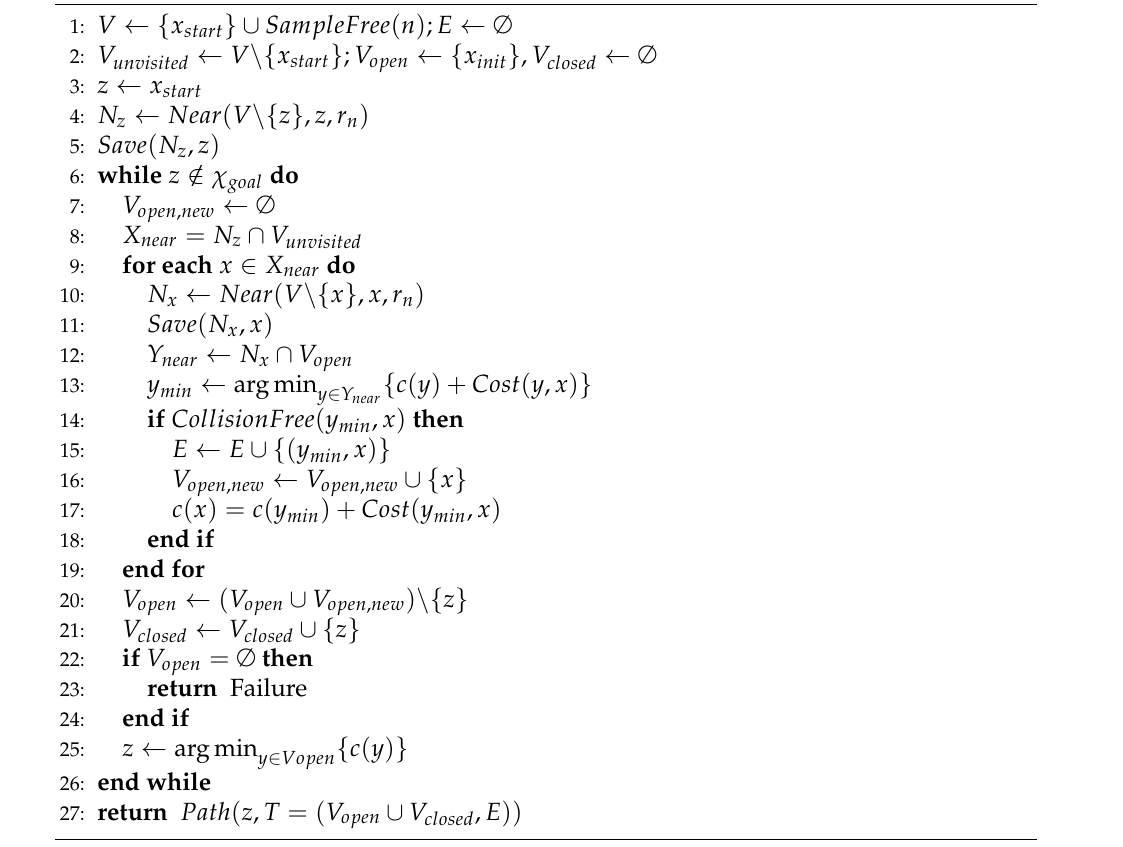
Algorithm A1 Fast marching tree: from a sampling composed of n samples, the algorithm creates the graph. At each step, the minimum cost node is selected and the algorithm tries to connect these neighbours (nodes at a distance lower than a radius depending on the number of samples) to the graph